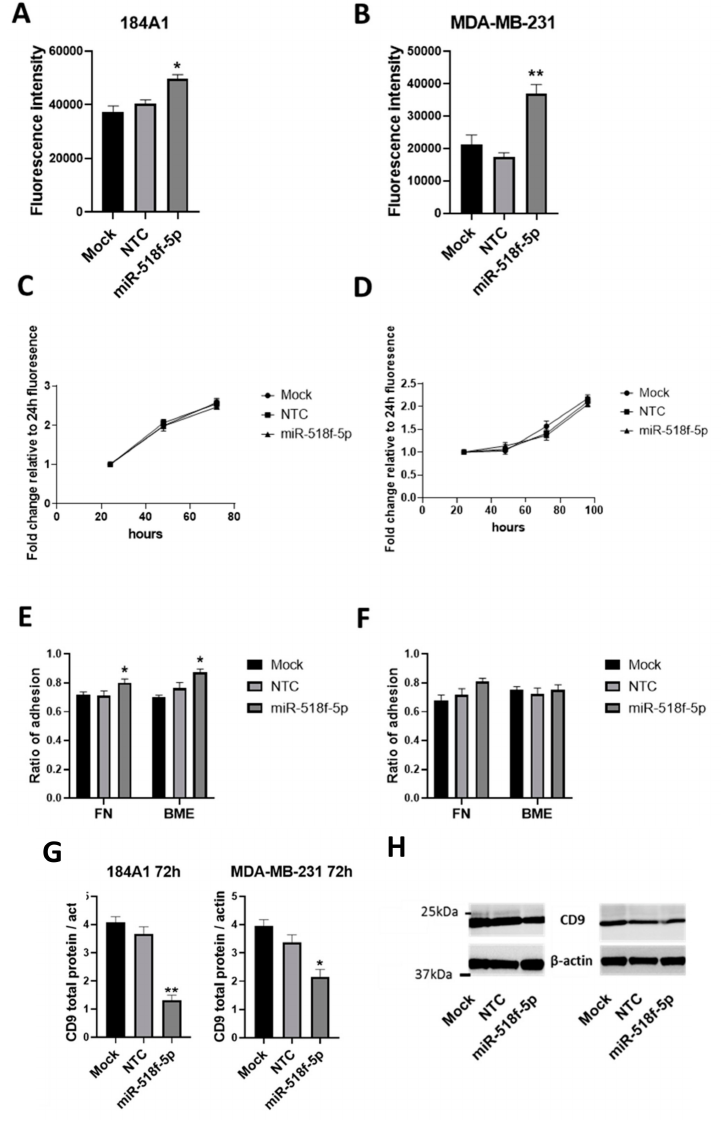
Figure 2. Transfection of miR-518f-5p mimic increases breast cell migration and decreases CD9 protein levels. ( A ). Cell migration in 184A1 cells following transfection of a miR-518f-5p mimic assessed using transwell migration assay. ( B ). Migration of MDA-MB-231 cells following transfection of miR-518f-5p mimic. Migration assay results are shown as fluorescence intensity (arbitrary units), * p = 0.02, ** p = 0.002. ( C ). Proliferation of 184A1 cells using the resazurin assay, after transfection of miR-518f-5p mimic. ( D ). MDA-MB-231 proliferation following transfection of a miR-518f-5p mimic, as measured using resazurin assay. Cell proliferation results are shown as fold change fluorescence relative to 24 h fluorescence (arbitrary units). ( E ). Changes in cell adhesion to basement membrane extract (BME) and fibronectin (FN) were assessed using an adhesion assay, following transfection with miR-518f-5p mimic in 184A1 cells. ( F ). Cell adhesion was assessed in MDA-MB-231 cells following transfection of miR-518f-5p mimic. Adhesion results are expressed as a ratio of adhesion (fluorescence intensity of adherent cells compared to total seeded cells, arbitrary units), FN: * p = 0.04, BME: * p = 0.01, n = 3. ( G ). Total CD9 protein expression was measured using SDS-PAGE and western blotting, following transfection of a miR-518f-5p mimic in 184A1 (left) and MDA-MB-231 cells (right) for 72 h. ( H ). Representative western blots of CD9 total protein expression following transfection with miR-518f-5p mimic for 72 h. Results shown as CD9 total protein normalized to beta actin protein expression, n = 3, * p = 0.04, ** p = 0.001. See Figure S1 for full western blotting